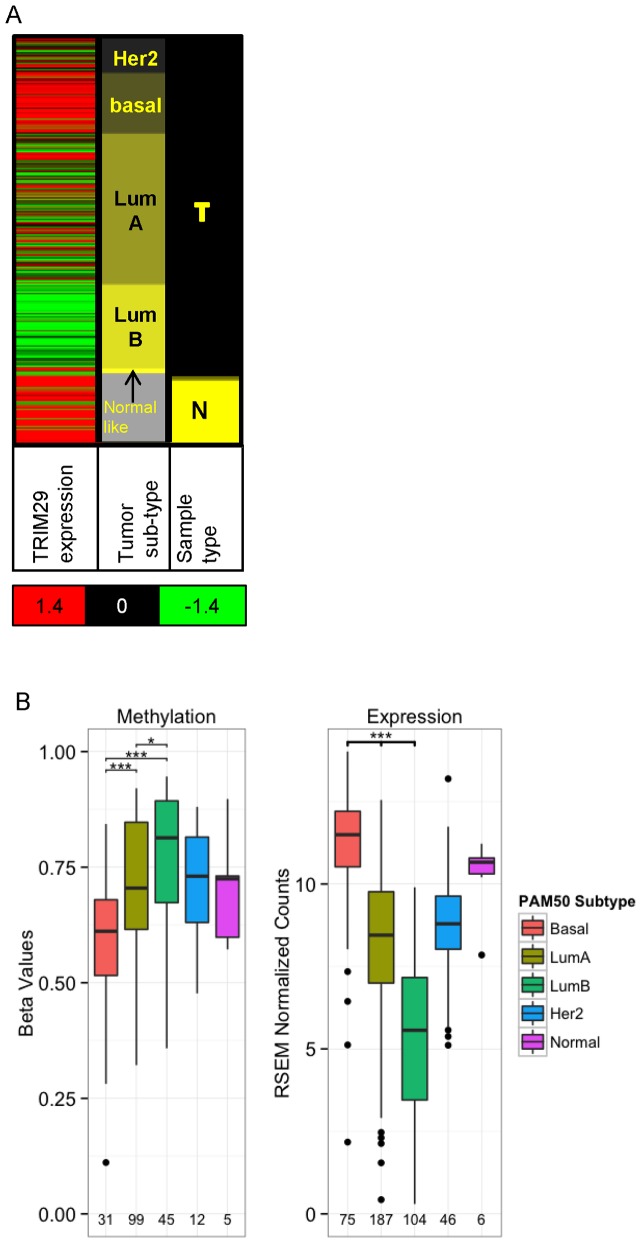
TRIM29 gene expression and promoter methylation varies in breast cancer subtypes.Analysis of TCGA data base shows (A) variable gene expression of TRIM29 in normal breast tissues (n = 97) and in breast tumor subtypes defined by the PAM50 classification: basal (n = 75), luminal A (n = 187), luminal B (n = 104), HER2 (n = 46), normal-like (n = 6). Heat map scale ranges from red (high) to green (low). (B) Variable methylation at the promoter of TRIM29 (Illumina probe #cg13625403) in breast tumor subtypes. Expression inversely correlates with promoter methylation. Data was selected from TCGA data base as described in methods. Number of samples indicated at the bottom, ***p<0.001, *p<0.01, P-values between groups were calculated using Welch's corrected t-test.